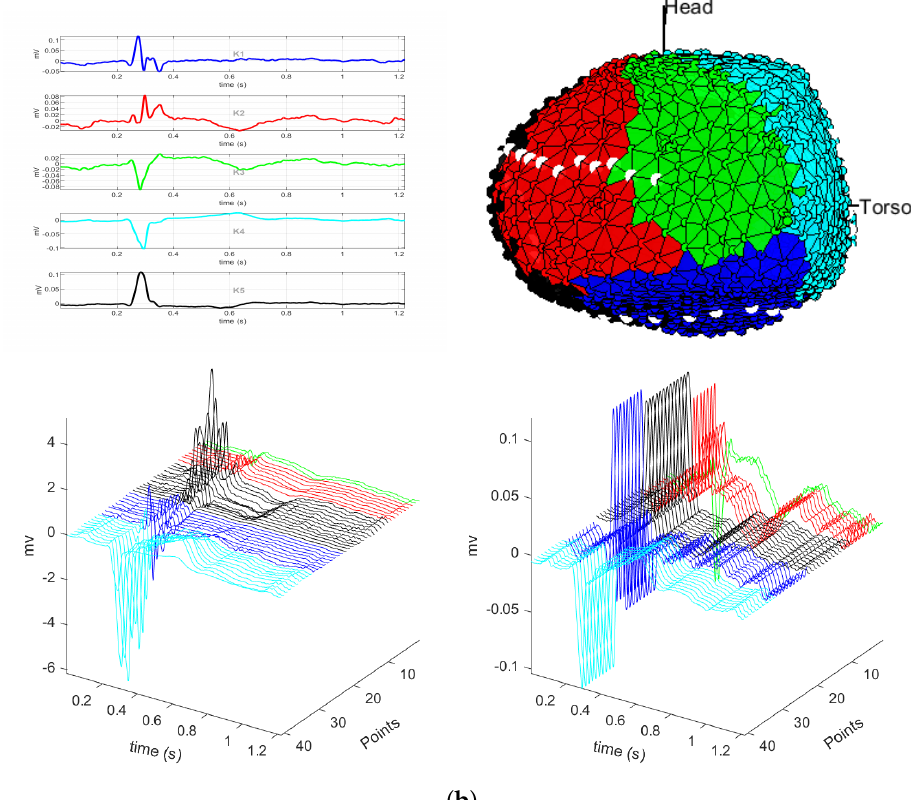
Figure 4. Unipolar EGM in the presence of infarction, using correlation distance with K = 4 ( a ) and with k = 5 ( b ). Panel contents are similar to the ones described in Figures 2 and